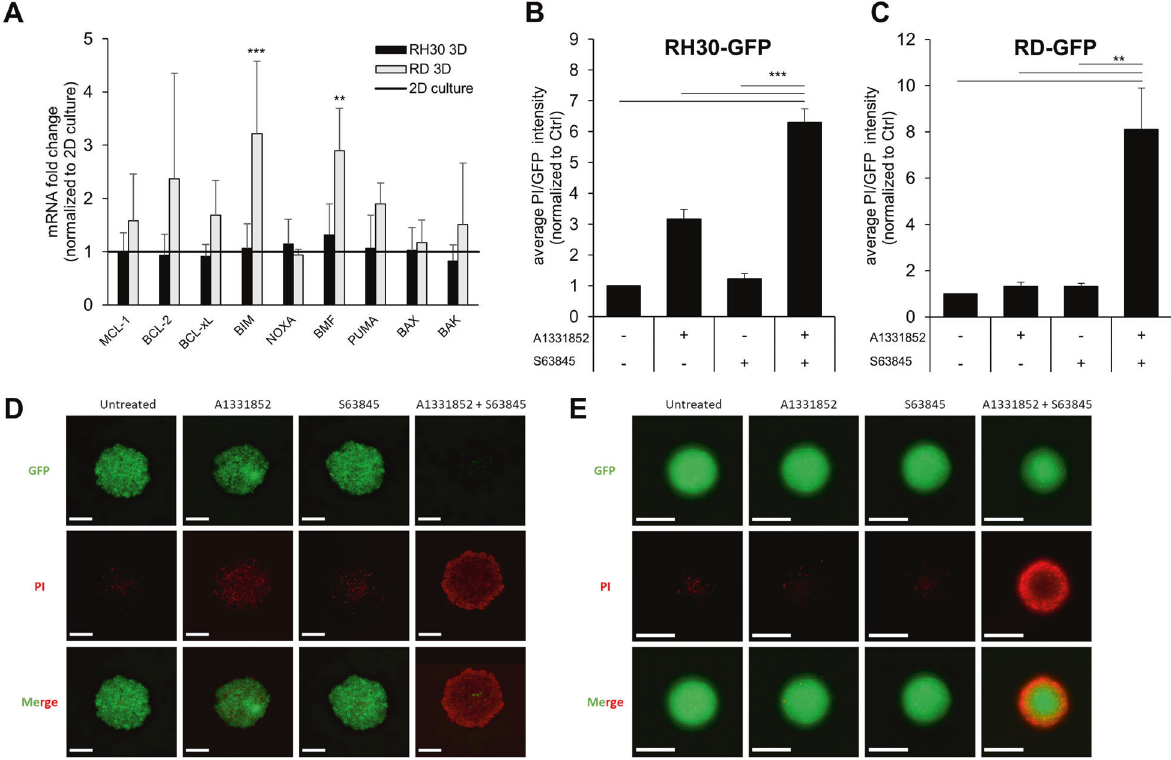
Fig. 3 Microscopic analysis con fi rms cell death induced by BH3 mimetics. A mRNA expression levels of BCL2 family members were compared in 3D spheroids and 2D culture of RH30-GFP and RD-GFP cells by qRT-PCR. Data shown are mean + SEM ( n = 4). B – E RH30-GFP or RD-GFP cells were cultured as 3D spheroids for 3 days before exposure to A1331852 (0.25 μ M RD-GFP, 0.1 μ M RH30-GFP) or S63845 (0.3 μ M RD- GFP, 0.03 μ M RH30-GFP) either alone or in combination for 48 h. Cell death was assessed by PI staining for 30 min before analysis. B , C PI and GFP fl uorescence was quanti fi ed and expressed as the ratio of PI/GFP. Data shown are mean + S.D. ( n = 3), ** p < 0.01; *** p < 0.001. D – E Exemplary images are shown for PI and GFP fl uorescence. Scale bar equals 500 μ